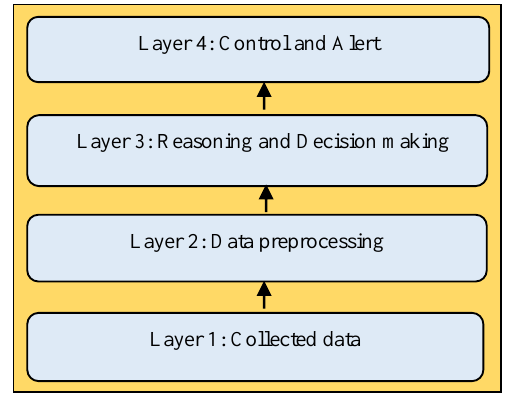
Figure 2. Smart system architecture in a smart city (Gaur et al. 2015)